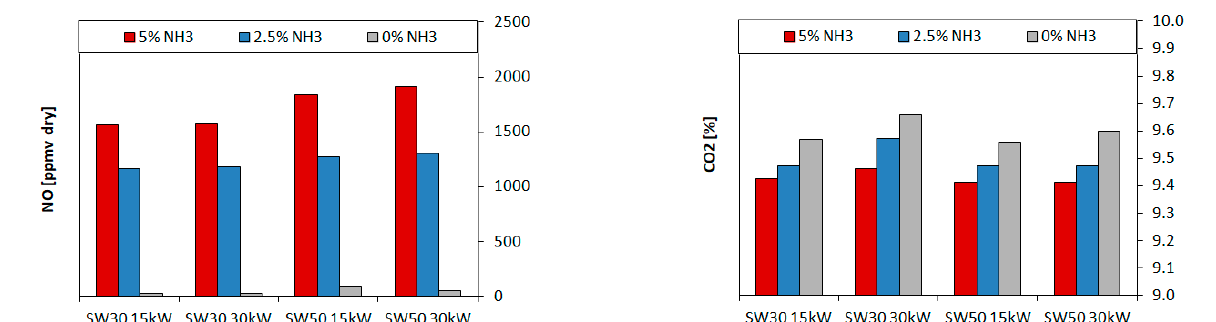
Figure 4. Comparison of the experimental NO and CO 2 emission at the outlet for the different swirlers and firing rates, φ = 0.71 (6% O 2 ).